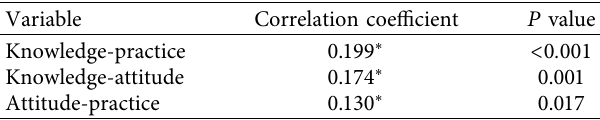
Table 6: Correlation analysis of knowledge, attitude, and practice.